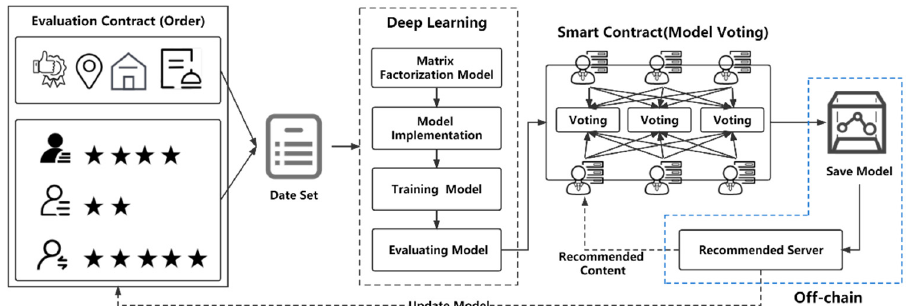
Figure 25. Smart contract-based deep learning recommendation model.